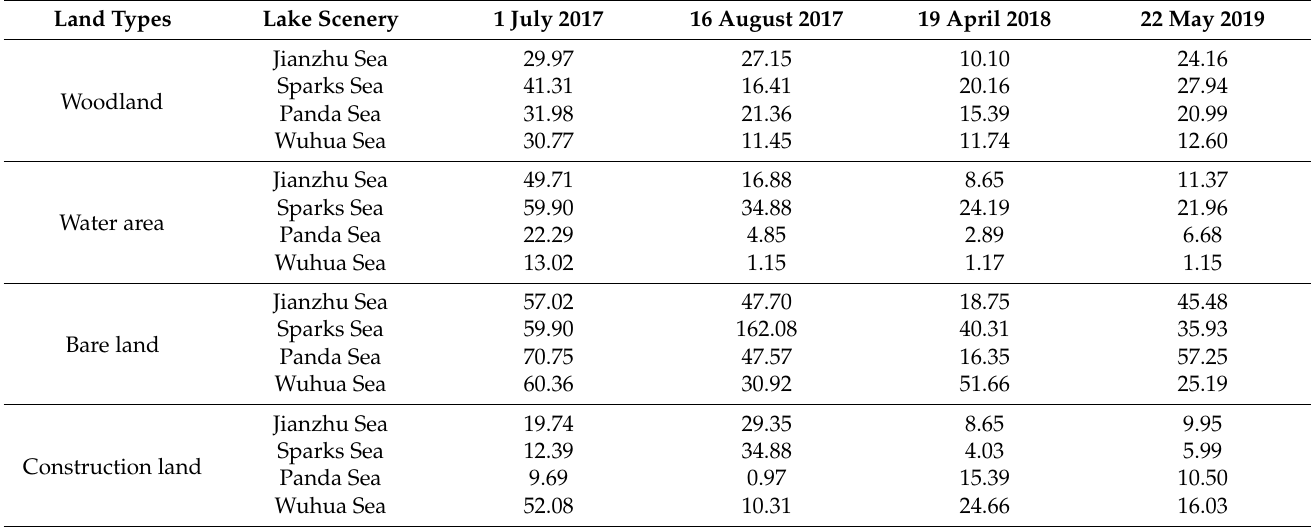
Table 6. Comparison table of the patch density indexes in different periods before and after the earthquake (km 2 ).